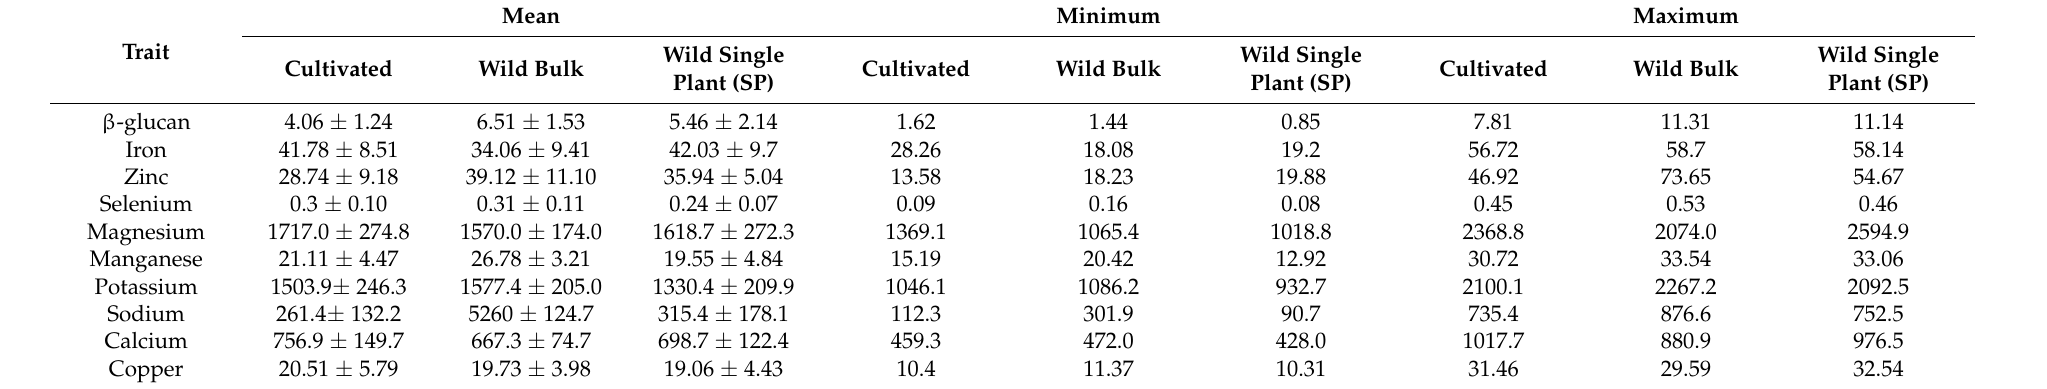
Table 5. Mean +/ − standard deviation and range of β -glucan and microelement contents in cultivated barley germplasm and Hordeum spontaneum accessions evaluated as bulk seeds and single plant seeds grown at Marchouch station during 2017_18